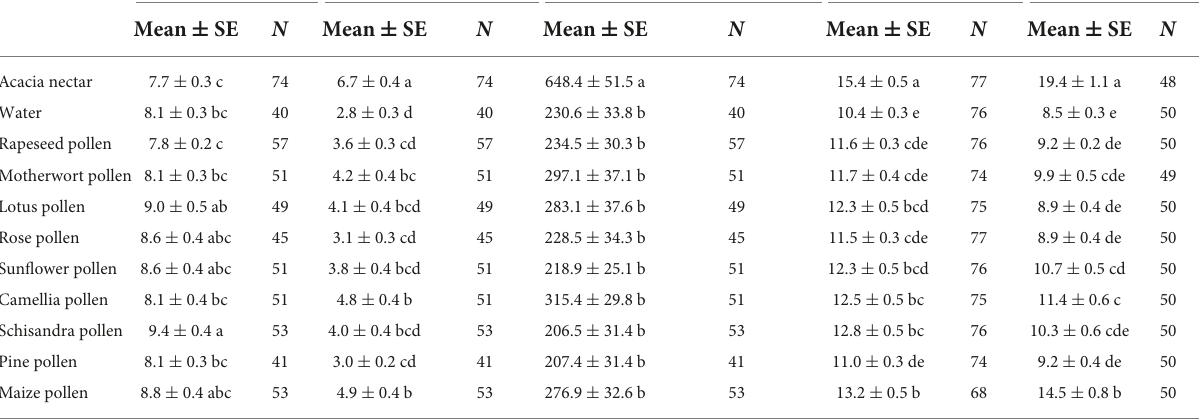
TABLE 2 Means ( ± SE) for longevity and fecundity variables for adults of Mythimna separata on different diets. Diet